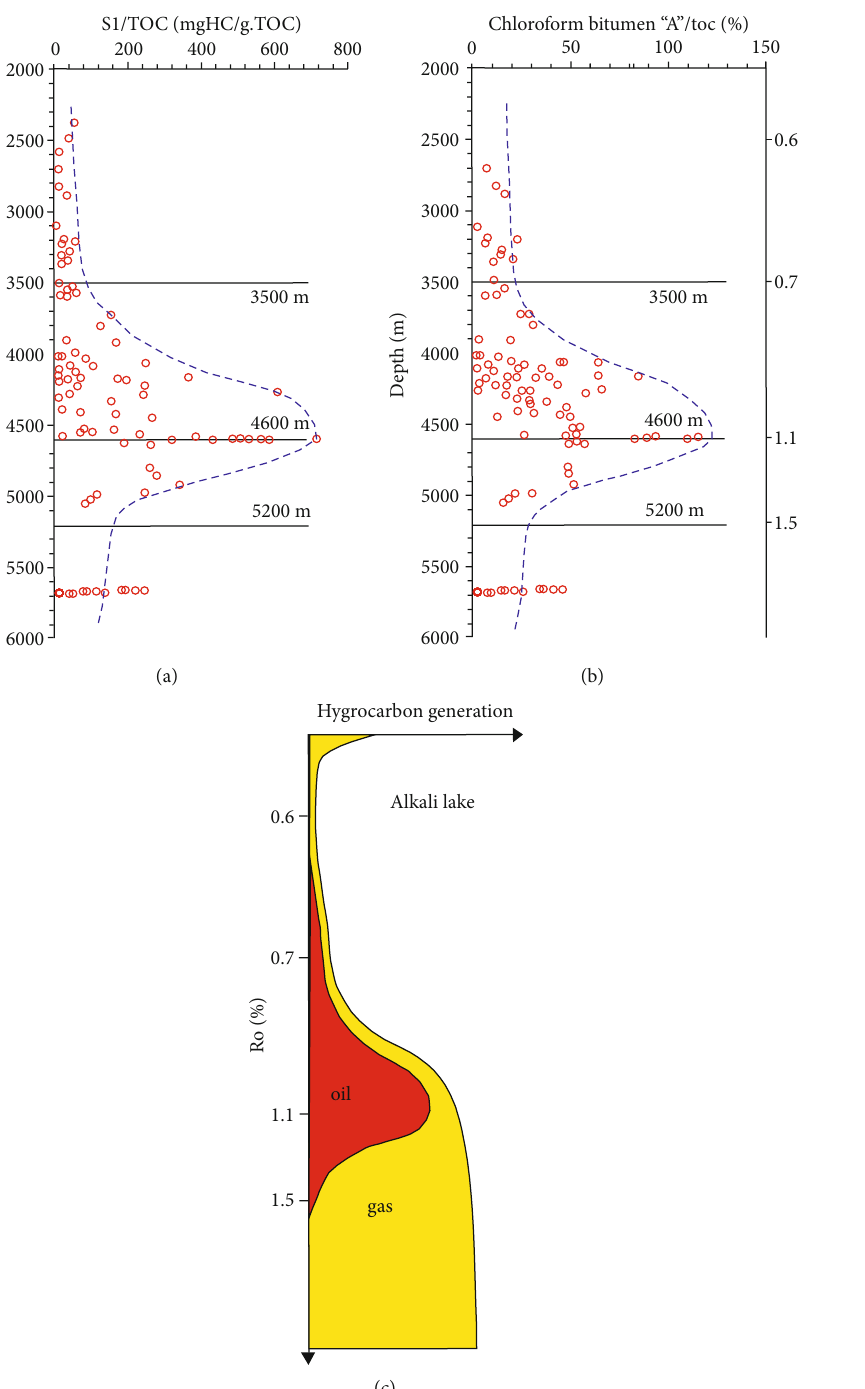
Figure 14: Relationships between hydrocarbon generation and burial depth in the Fengcheng Formation source rocks. (a) Main oil generation stage according to changes in S chloroform asphalt “ A ” /TOC with depth and R